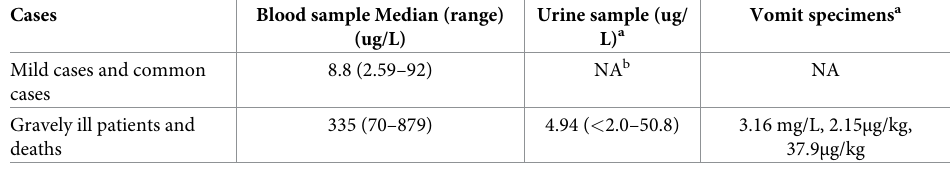
Table 4. Results of laboratory analyses of bongkrekic acid in clinical specimens from some patients in China, 2010–2020.